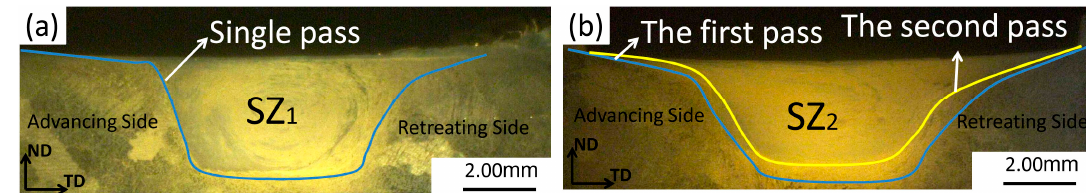
Figure 2. Macrographs of as-FSP specimens: ( a ) one-pass SFSP; ( b ) two-pass SFSP.